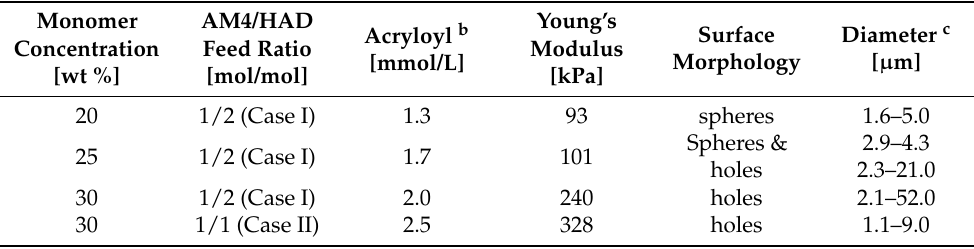
Figure 4. A photo (I-20w-90d) and stress-strain curves of AM4-HDA porous polymers Case I, feed molar ratio of AM4/HDA: 1/2, reaction temperature: 90 °C, ( a ) I-20w-90d, ( b ) I-25w-90d, and ( c ) I-30w-90d. Table 1. Mechanical properties of AM4-HDA porous polymers a